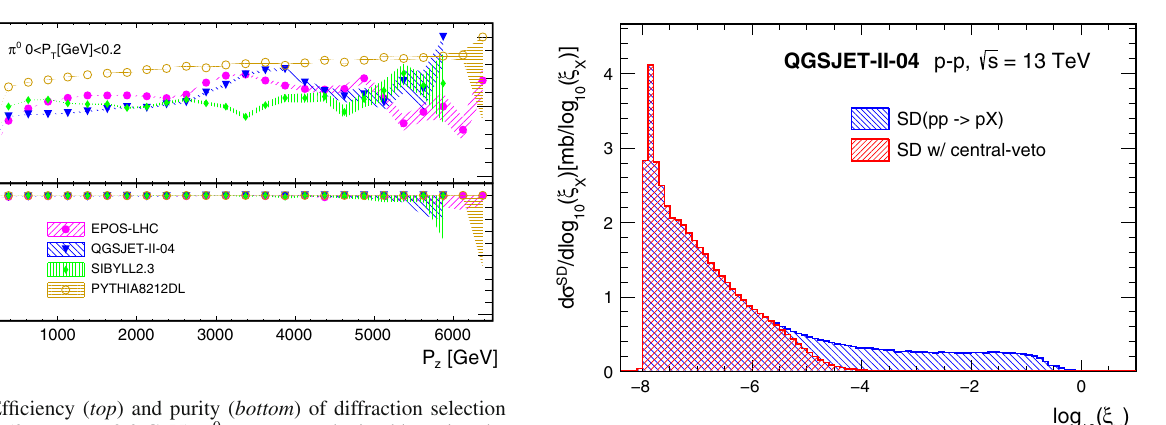
Fig. 10 Efficiency ( top ) and purity ( bottom ) of diffraction selection for the VF (0 < p T < 0 . 2 GeV) π 0 p z spectra obtained by using the central-veto technique